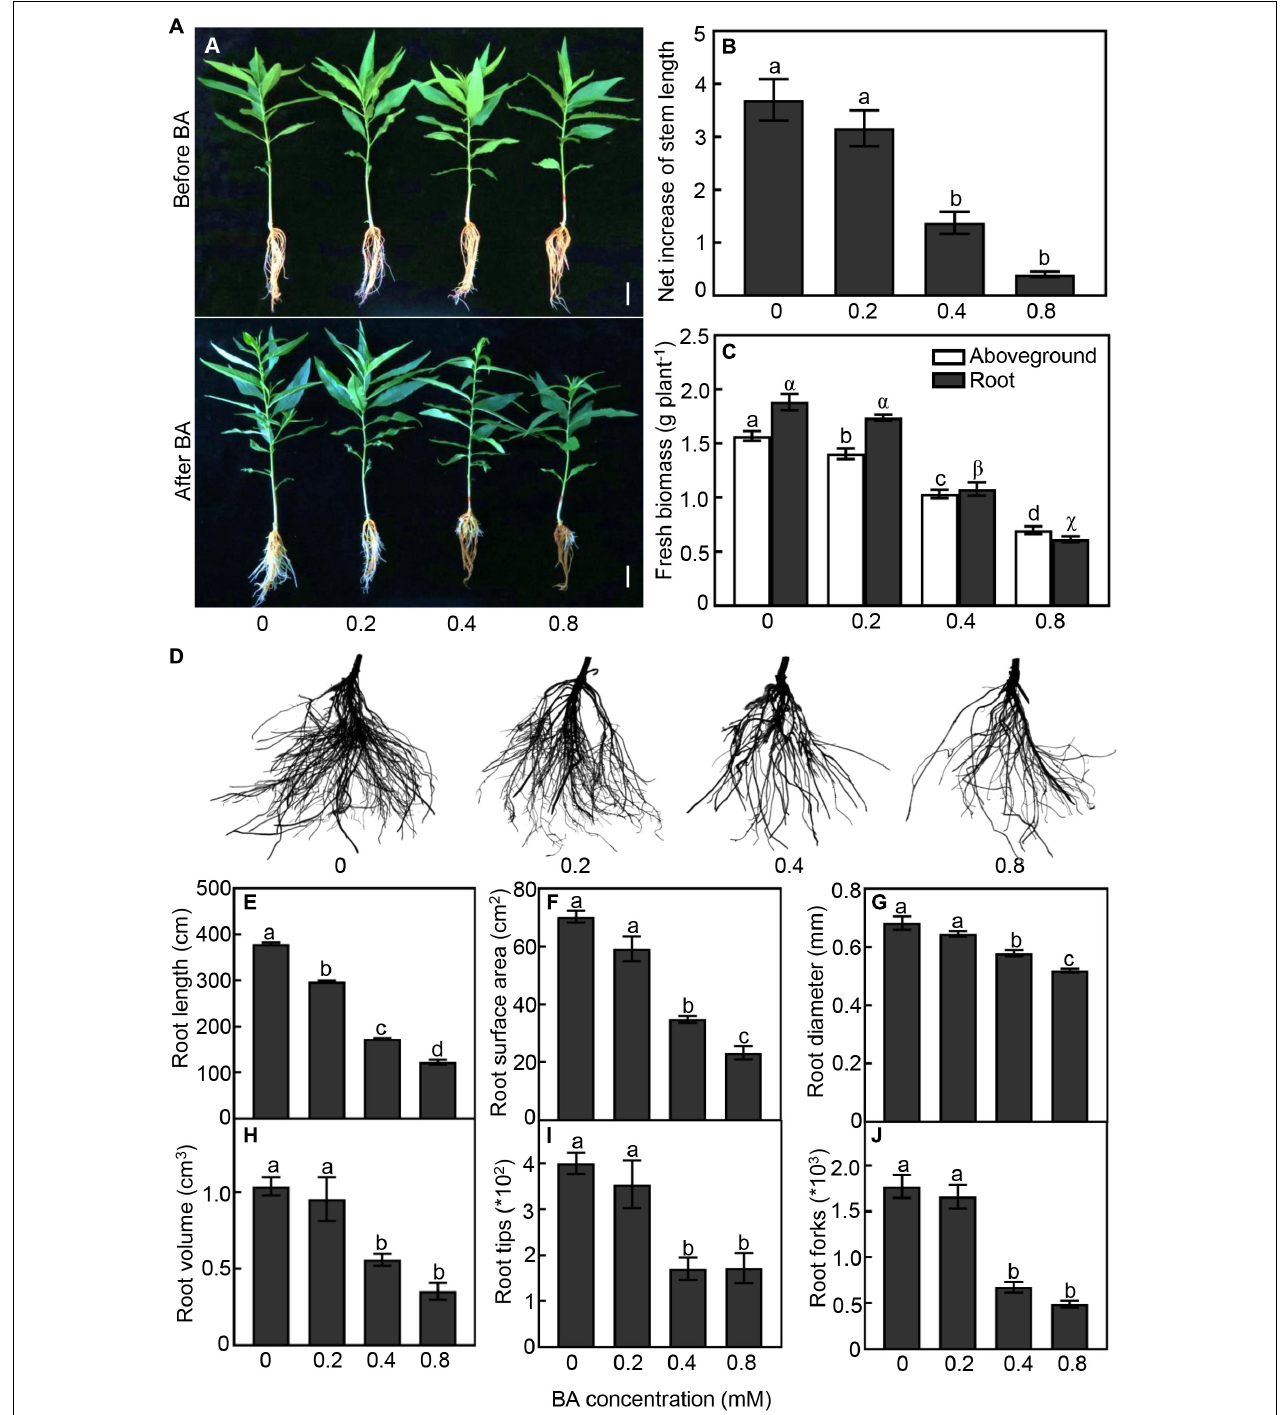
FIGURE 1 | Growth performan ce of peach seedlings in response to different concentrations of benzoic acid (BA) treatment for 120 h. (A) Morphological change of peach plants before and after BA treatment. Bar represents 2 cm. (B) Net increase of stem length was calculated by the height at 120 h after BA treatment and the height at the onset of BA treatment. (C) Aboveground and root fresh biomass. (D) Morphological change of root system. (E) Total root length. (F) Root surface area. (G) Average of root diameter. (H) Root volume. (I) Number of root tips. (J) Number of root forks. Error bars indicate ± SE. Different letters on top of bars indicate significant difference between BA treatments at P <